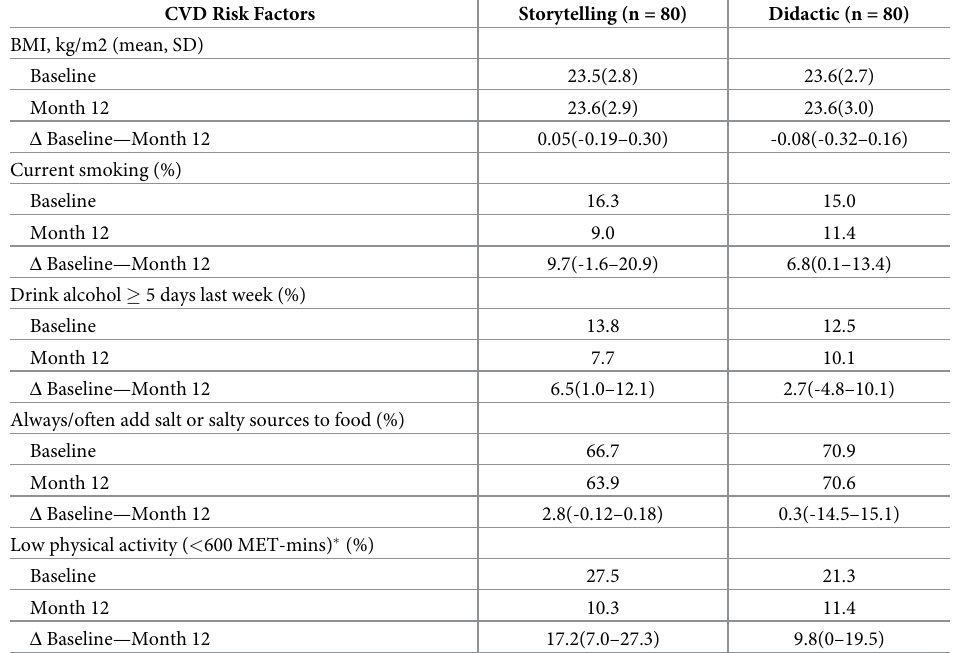
Table 4. Improvement Over-time (95% CI) in Risk Factors for Cardiovascular Disease (CVD) after Exposure to Storytelling and Didactic Interventions §